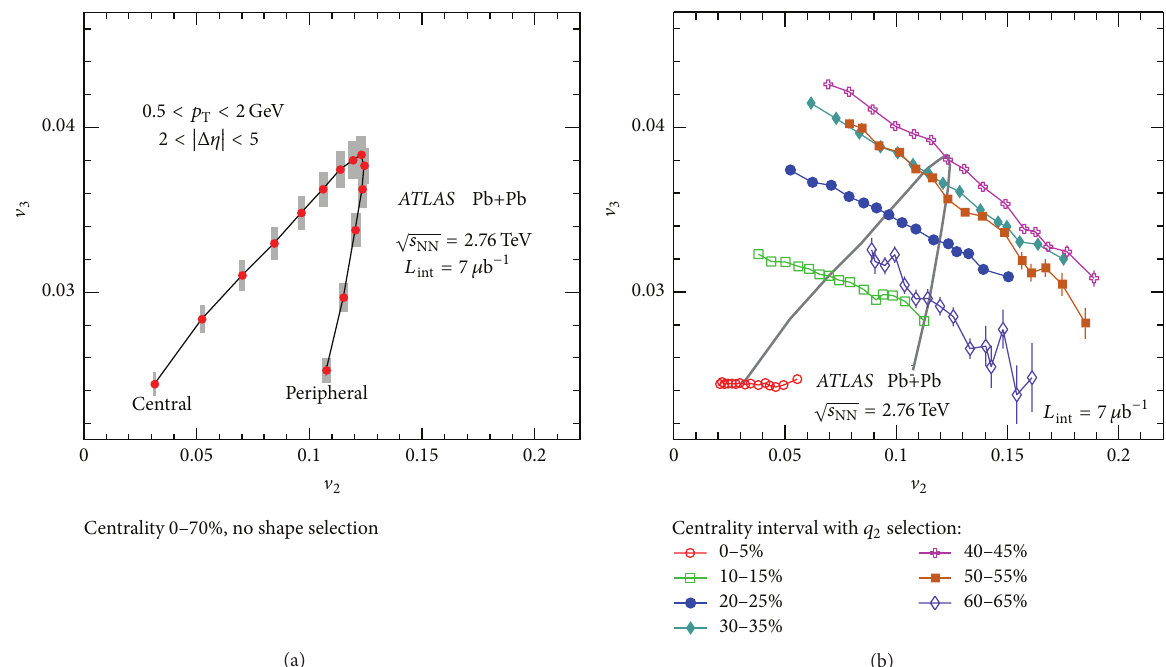
Figure 3: The correlation of V 2 ( 𝑥 -axis) with V 3 ( 𝑦 -axis) measured in 0.5 < 𝑝 𝑇 < 2 GeV/ 𝑐 . (a) shows V 2 and V 3 values for fourteen 5% centrality intervals over the centrality range of 0–70% without event shape selection. (b) shows V 2 and V 3 values in 15 𝑞 2 intervals in seven centrality ranges (markers) with larger V 2 value corresponding to larger 𝑞 2 value. Figures are taken from [45].